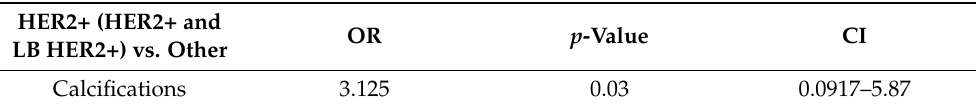
Table 8. Effect of calcifications in HER2+ vs. other breast cancer subtypes. HER2+ (HER2+ and LB HER2+) vs. HER2+ (HER2+ and